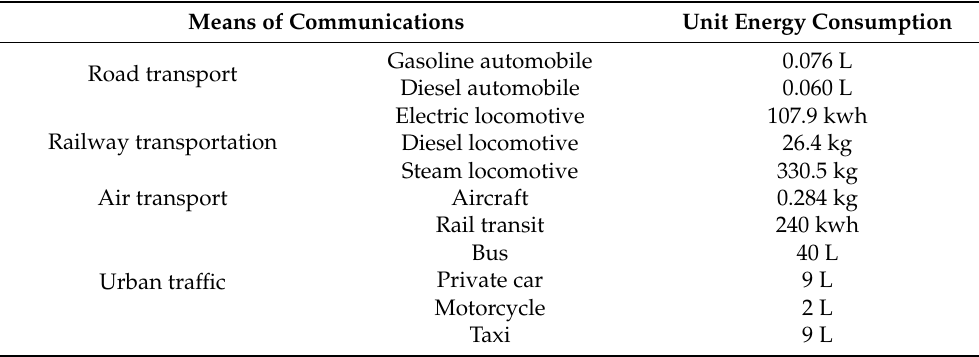
Table 1. Energy consumption per unit of each mode of transport. Means of Communications Unit Energy Consumption Road